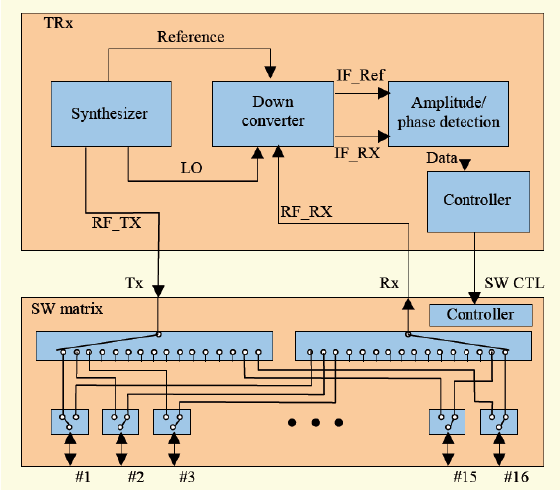
Figure 8. Schematic of the system developed by Son et al. [68]. Reprinted with permission from